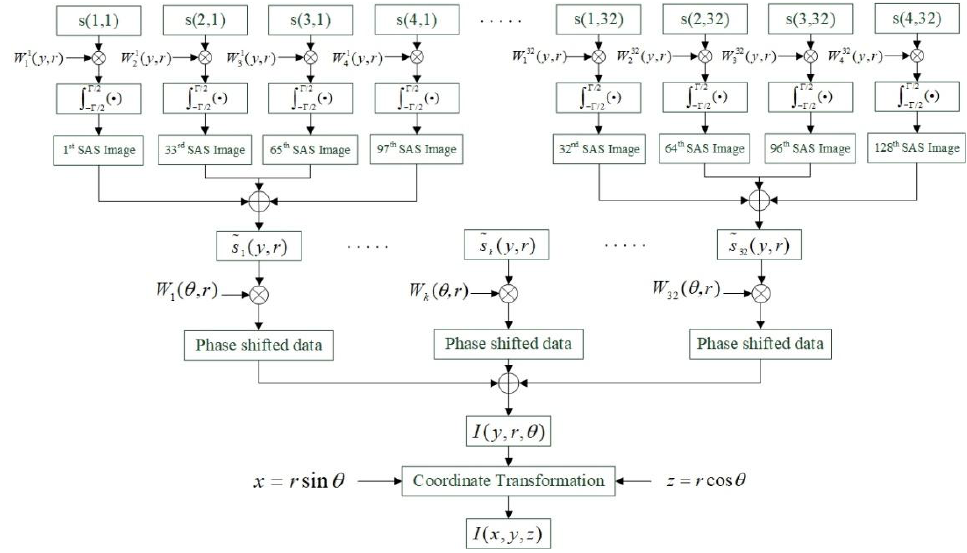
Figure 2. Processing scheme of MBSAS imaging system.